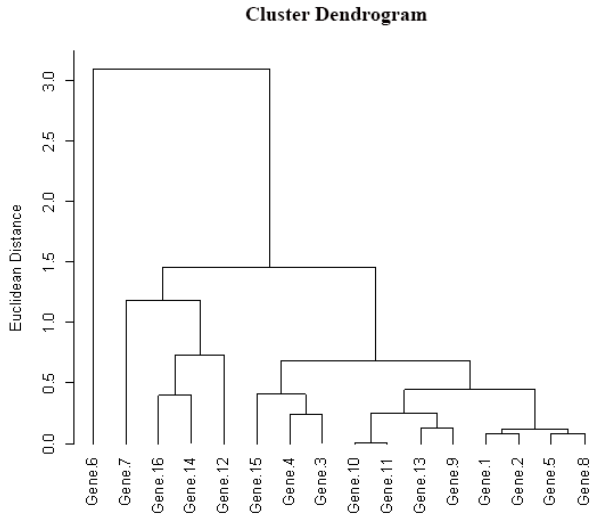
Fig. 5 Fig. 5. Gene Cluster Dendrogram of mussel B. azoricus at 24h post-infection through Euclidean distance, using UPGMA method.